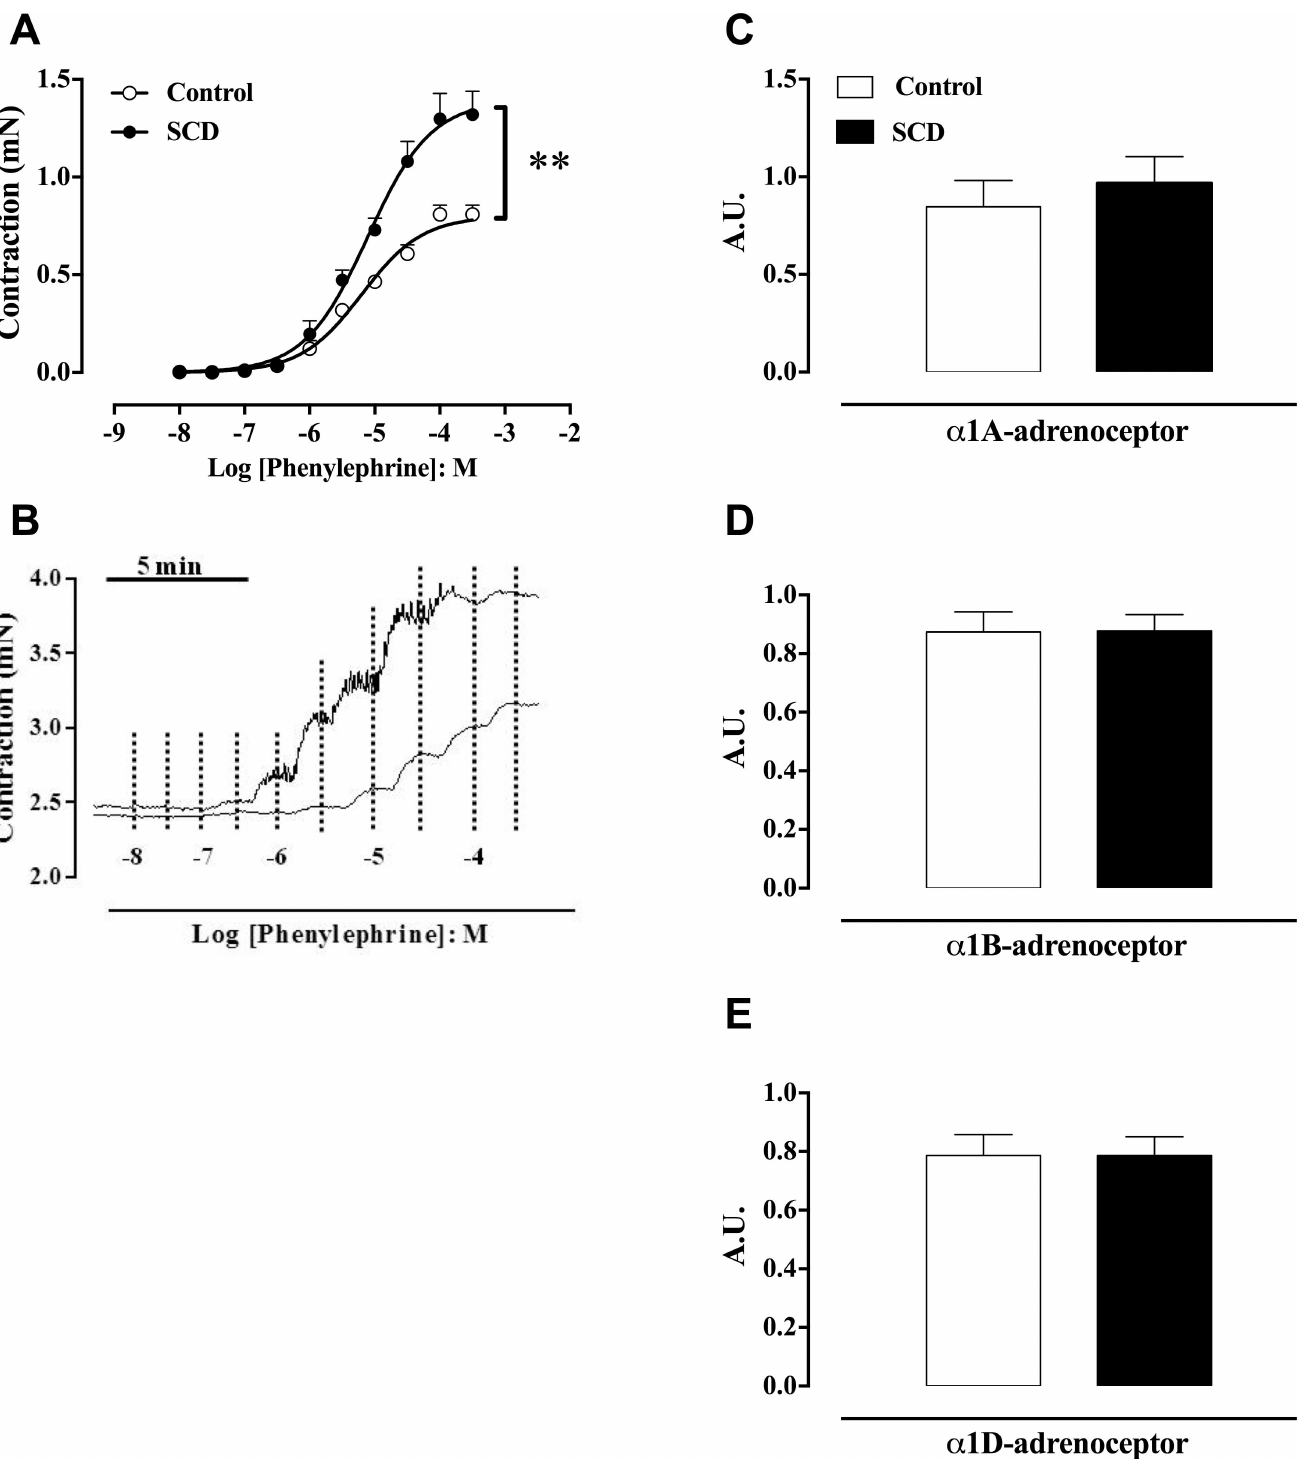
Fig 2. ( A ) Contractileresponses to phenylephrine and ( B ) representative tracings of contractileresponseto phenylephrine in corpus cavernosumstrips from control and SCD mice. Data are shown in mN, and represent the mean ± SEM of 5 to 6 mice in each group. mRNA expressions of ( C ) α 1A - ( D ), α 1B - ( E ), α 1D -adrenoceptors in corpus cavernosumfrom control and SCD mice. The mRNA expressionlevel of each gene was normalizedby GAPDH and β - actin expression. Data represent the mean ± SEM of 5 mice in each group. Values are expressedin arbitrary units (A.U.). Singleasterisk indicatesp < 0.05 vs control group. (Student’sunpaired t